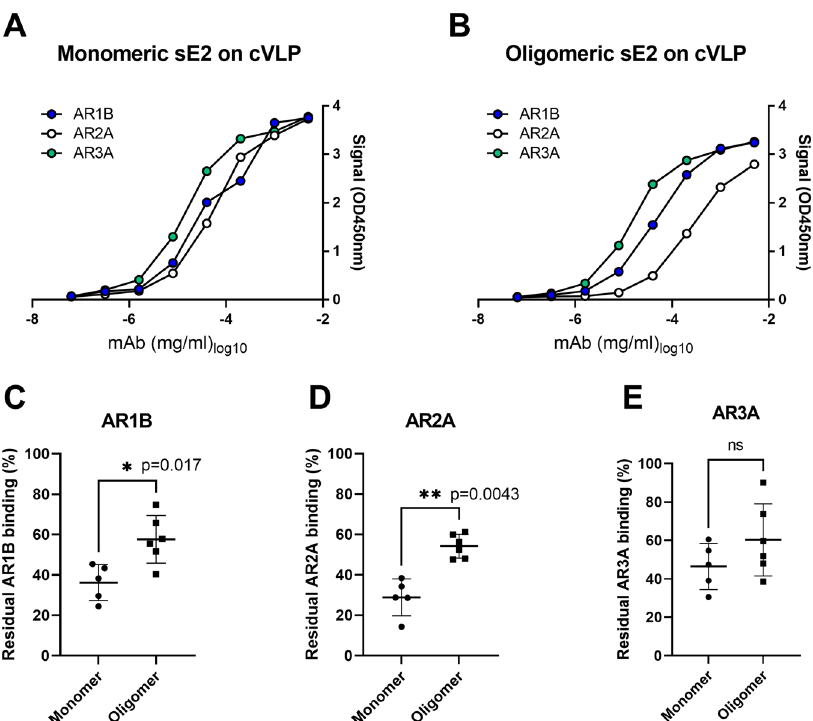
Fig. 4 Oligomeric sE2-cVLPs present less AR2A epitopes than monomeric sE2-cVLPs and induces signi fi cantly less AR1B- and AR2A- speci fi c antibodies in mice. Dose-response ELISAs against cVLPs coupled either to ( A ) monomeric or ( B ) oligomeric sE2 using human monoclonal anti-HCV antibodies AR1B, AR2A, or AR3A. ELISAs were done in single replicates using anti-human IgG coupled to HRP and subsequently, a colorimetric TMB substrate signal was detected. C – E Competition ELISAs were performed using week 6 mouse sera in two replicates in a 3-fold dilution series, starting at 1:200, to block binding of AR1B, AR2A, or AR3A (see Supplementary Fig. 2 for full dose-response analysis). Residual binding was calculated by comparing to wells without blocking serum and converted to percent. Values represent mean and the error bars represent the standard deviation. Pre-immune sera were shown to have no inhibitory effect for the three tested antibodies (Supplementary Fig. 2). Statistical signi fi cance testing was done using non-parametric Mann – Whitney tests (Graphpad Prism 9.2.0) with a signi fi cance threshold set at